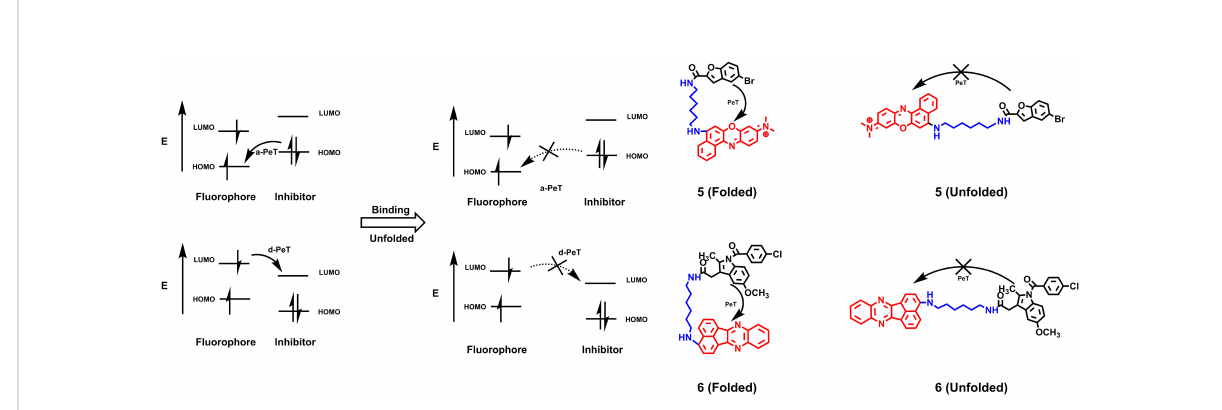
FIGURE 2 The quenching mechanism of PeT effects and AfPIs are designed based on PeT effects. When probes do not bind to the proteins, the fl uorescence is quenched by Pet effects. After binding to proteins, the folded structure is open and the PeT effect disappears, resulting in the release of fl uorescence (HOMO, highest occupied molecular orbital; LUMO, lowest unoccupied molecular